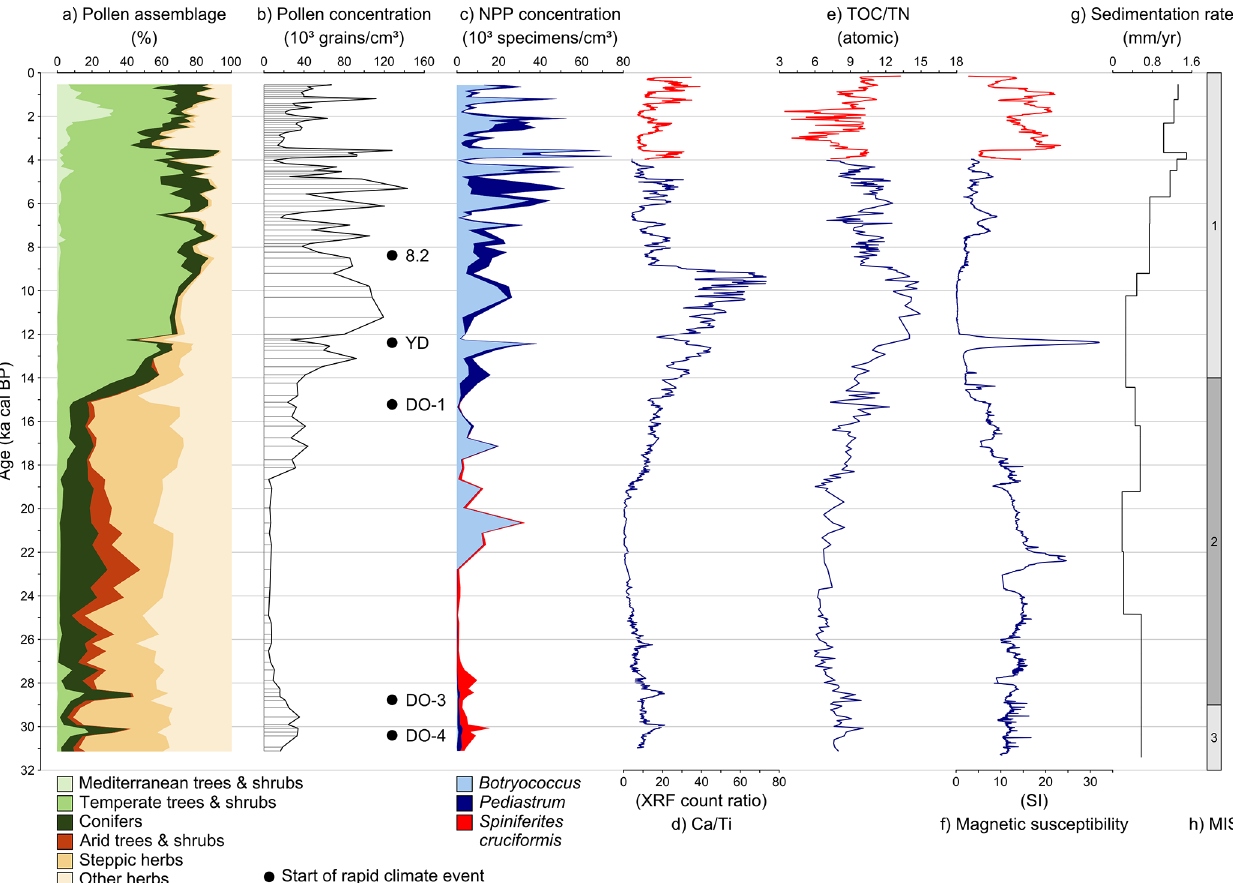
Figure 5. Comparison of different proxies inferred from Lake Iznik sediments: (a) pollen assemblage, (b) total pollen concentrations, (c) non- pollen palynomorph (NPP) concentrations, (d) calcium/titanium (Ca / Ti) ratios (represent the lake-wide endogen carbonate precipitation; relative changes between the red curve (Ülgen et al., 2012) and the blue curve (Roeser et al., 2012) are comparable), (e) total organic carbon/total nitrogen (TOC / TN) ratios (relate to catchment vegetation cover and are influenced by the distance to the shoreline; hence, differences between the red curve (Ülgen et al., 2012) and the blue curve (Roeser, 2014) most likely result from different coring locations), (f) magnetic susceptibility (relatable to the detrital input and the diagenetic remobilization of iron and sulfur; changes between the red curve (Ülgen et al., 2012) and the blue curve (Roeser et al., 2012) are most likely analytical artefacts), (g) sedimentation rates (Roeser et al., 2016), (h) marine isotope stages (MIS; Lisiecki and Raymo, 2005). Dots mark Dansgaard-Oeschger events (DO), the Younger Dryas (YD), and the 8.2